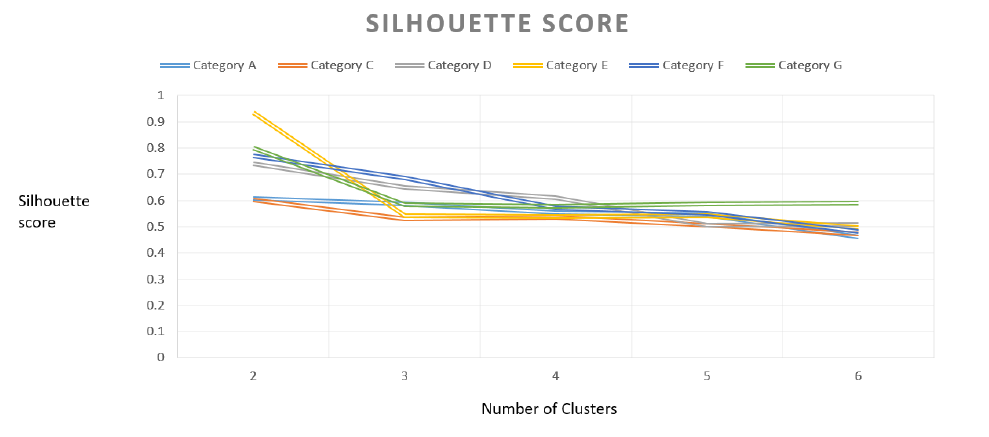
Figure 6. Determining Number of